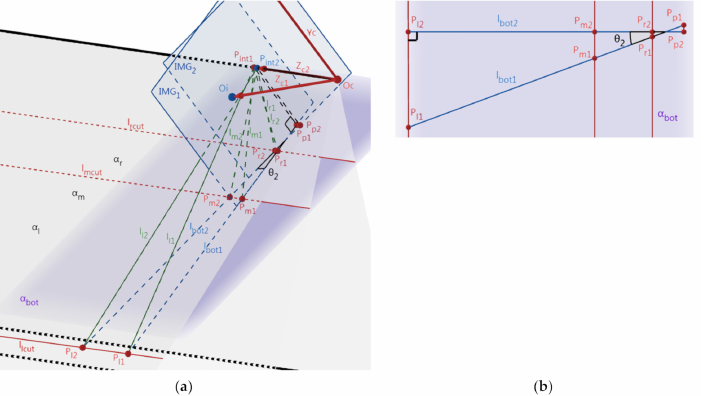
Figure 7. The imaging differences before and after step 2.2. ( a ) The side view of the image sensors. ( b ) The top view of the α bot